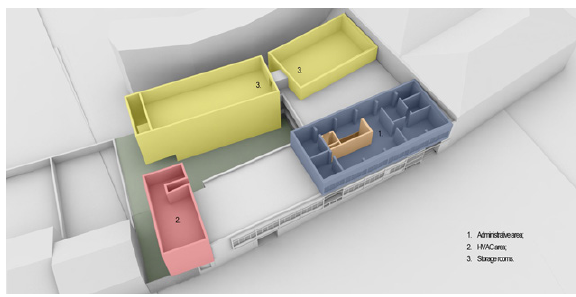
Figure 13. Proposed second floor